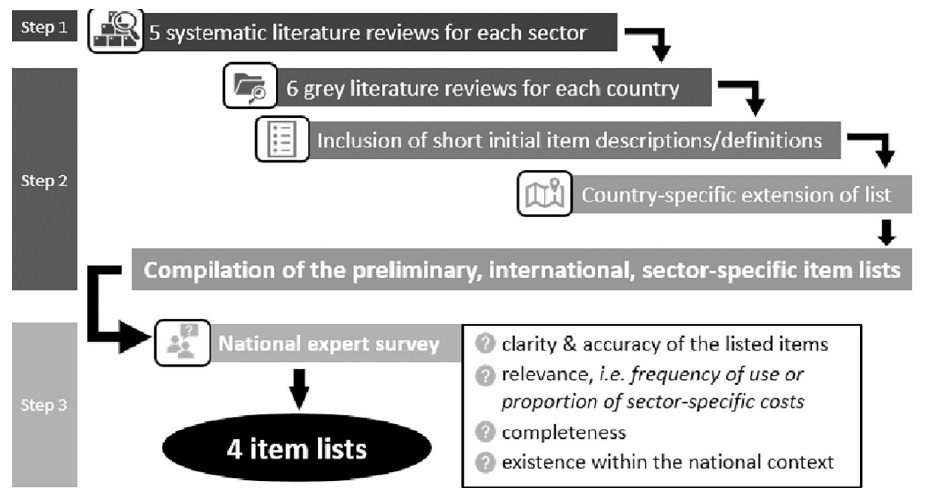
Fig 1. Iterative development process international sector-specific item